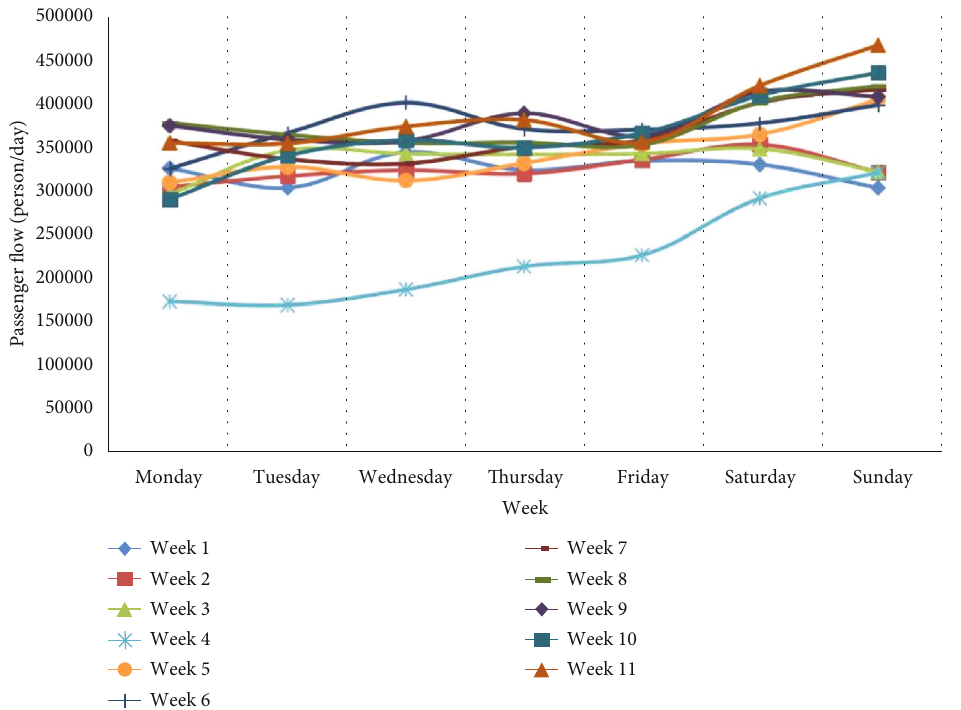
Figure 4: Periodic analysis of sampling passenger fl